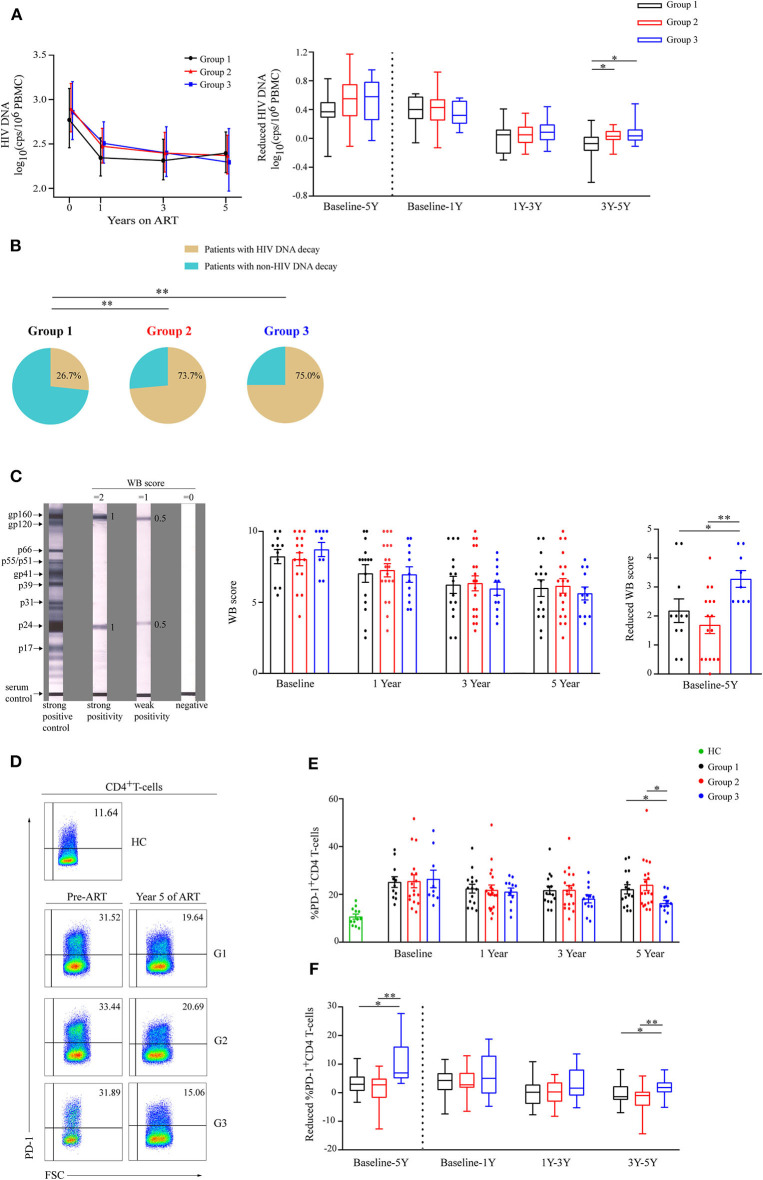
Analysis of viral decay among the three groups during ART. (A) Dynamics of HIV DNA are shown as geometric means (95% CI) among three groups during ART (left panel). Comparisons of reduced HIV DNA levels in three groups from baseline to year 5, from baseline to year 1, from years 1 to 3, and from years 3 to 5 (right panel). (B) The percentages of patients with reduced HIV DNA during years 3–5 of ART in the three groups. (C) Typical Western blot (WB) forms of strong positive control, strong reactive of gp160 and p24, weak reactive of gp160 and p24, and negative response are shown (left panel). Statistical analysis of WB score during ART (middle panel) and WB score decrease from baseline to year 5 (right panel) in three groups. (D) Representative flow cytometric data of PD-1 staining gated on CD4 T-cells. (E) Comparisons of the percentages of PD-1 expressions on CD4 T-cells in three groups during ART. (F) Changes in percentage of PD-1 expression on CD4 T-cells were compared in three different groups from baseline to year 5, from baseline to year 1, from years 1 to 3, and from years 3 to 5 (right panel). Group 1 (G1, n = 15 participants, 4 missing data at baseline), Group 2 (G2, n = 19 participants, 2 missing data at baseline), Group 3 (G3, n = 12 participants, 3 missing data at baseline), HC (health controls, n = 12 participants). In (C,E), data are mean ± SEM. In (right panel of A,F), boxes show median and IQR, and whiskers are minimum and maximum. *P < 0.05, **P < 0.01. CI, confidence interval; SEM, standard error of the mean; cps, copies.